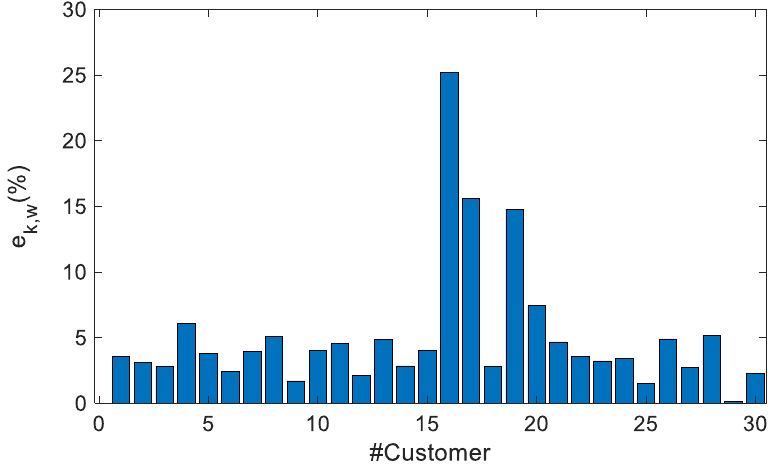
Figure 7. The partial error of the power profiles estimator, 𝑌 𝐴𝐵𝐴𝐵 ̂ , of cluster k = ABAB. The error is normalized by the contractual power of the cluster ABAB (P ABAB = 16.5 kW).